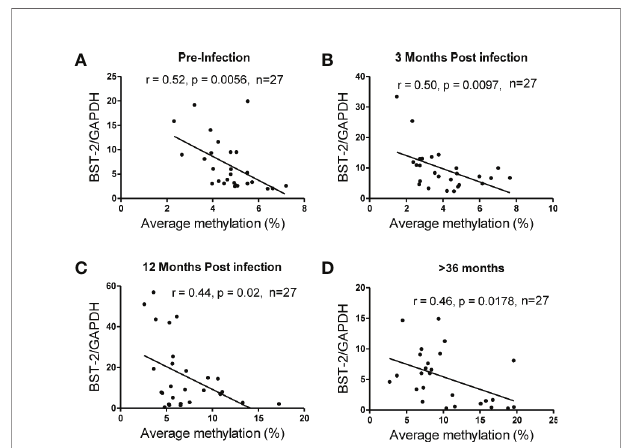
FIGURE 3 | Correlation of DNA methylation and BST-2 mRNA expression levels across HIV disease. Average methylation was calculated as the average methylation level across nine sites within 200bp upstream of the transcription start site. A strong negative correlation was observed at each of the time points examined for a set of n=27 matched samples at varying time points across disease progression. (A) pre-infection (r=-0.52, p=0.0056), (B) 3 months ’ post infection (r=-0.50, p=0.0097), (C) 12 months ’ post infection (r=-0.44, p=0.02) and (D) >36 months (r=-0.46, p=0.0178).